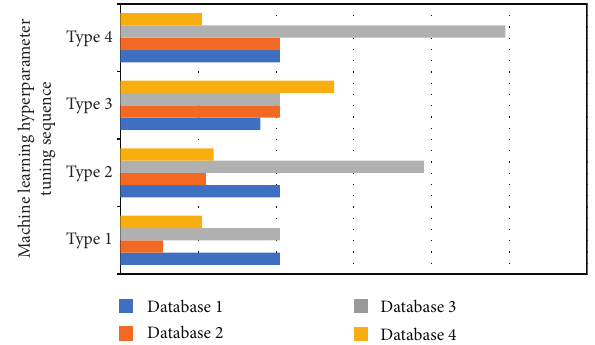
Figure 9: Responsiveness distribution of machine learning data series.